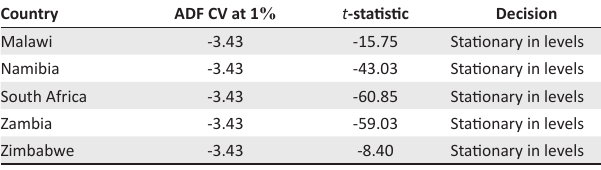
TABLE 3: Stationarity of market returns.